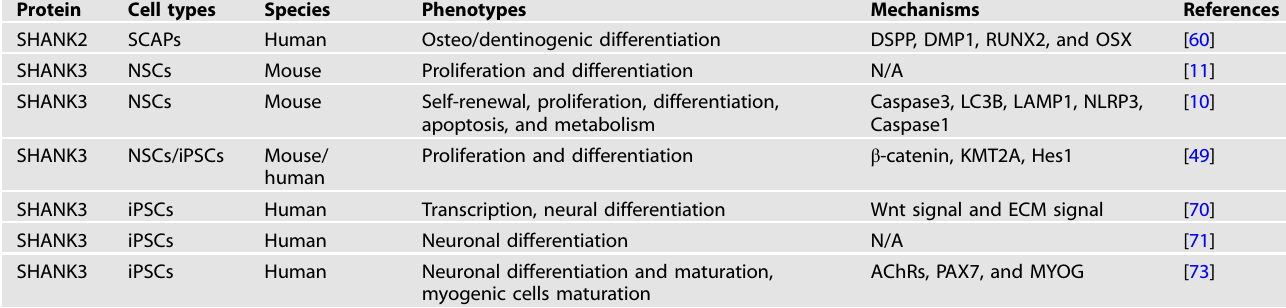
Table 2. The role of the SHANK family in regulating stem cell behaviors.